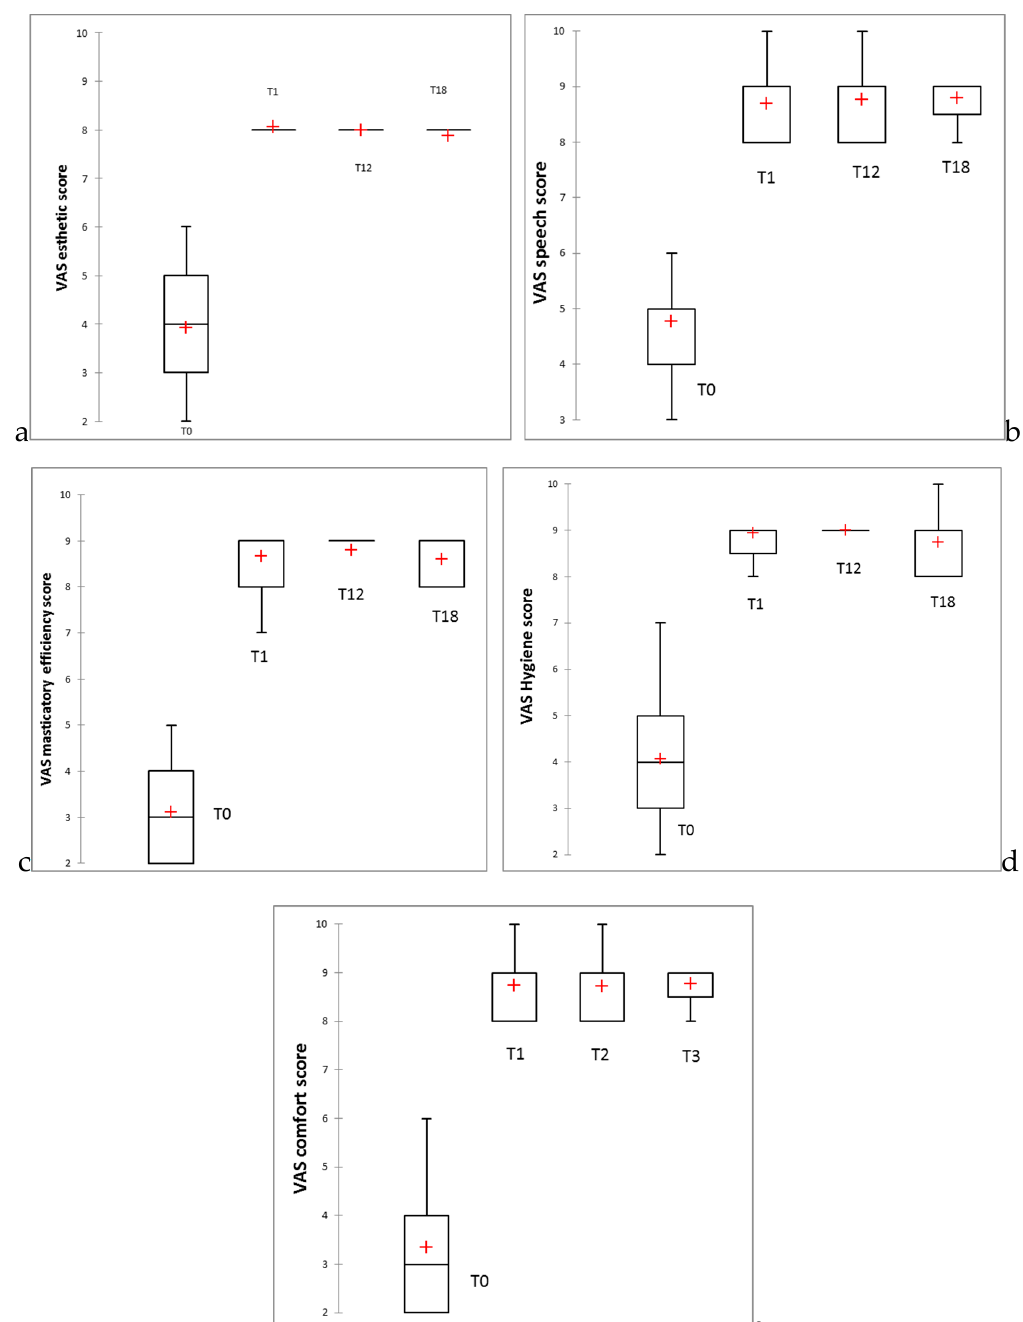
Figure 15. Boxplots for the changes in VAS overall scores: ( a ) aesthetic, ( b ) speech, ( c ) masticatory efficiency, ( d ) hygiene, ( e ) comfort.